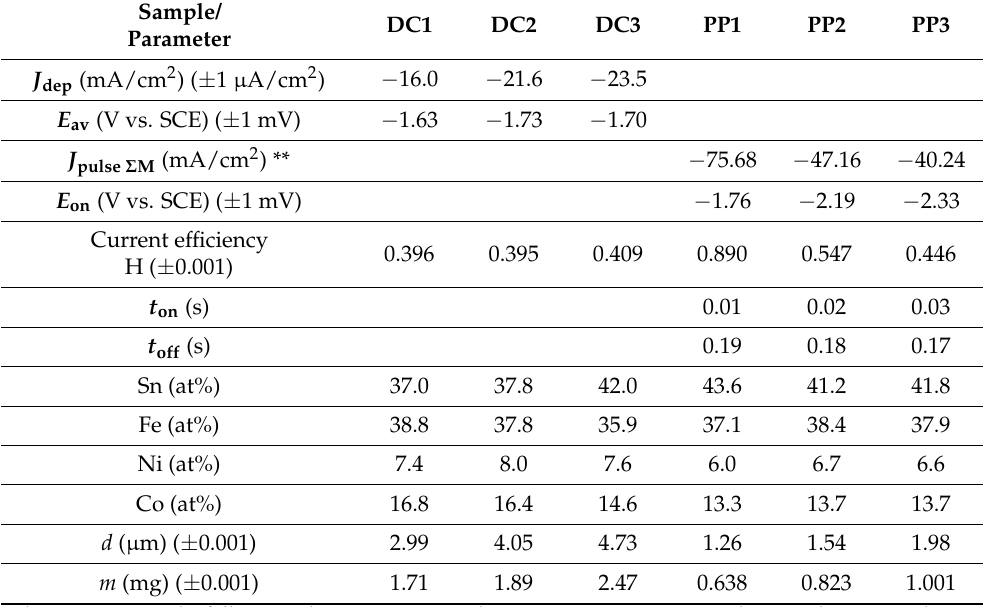
Table 2. Selected deposition parameters and composition of DC and pulse current (PP) plated Sn-Fe-Ni-Co quaternary alloys